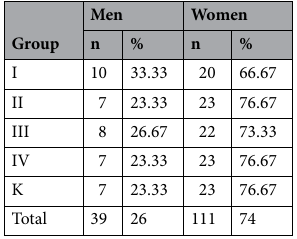
Table 2. Distribution of the study and control groups according to